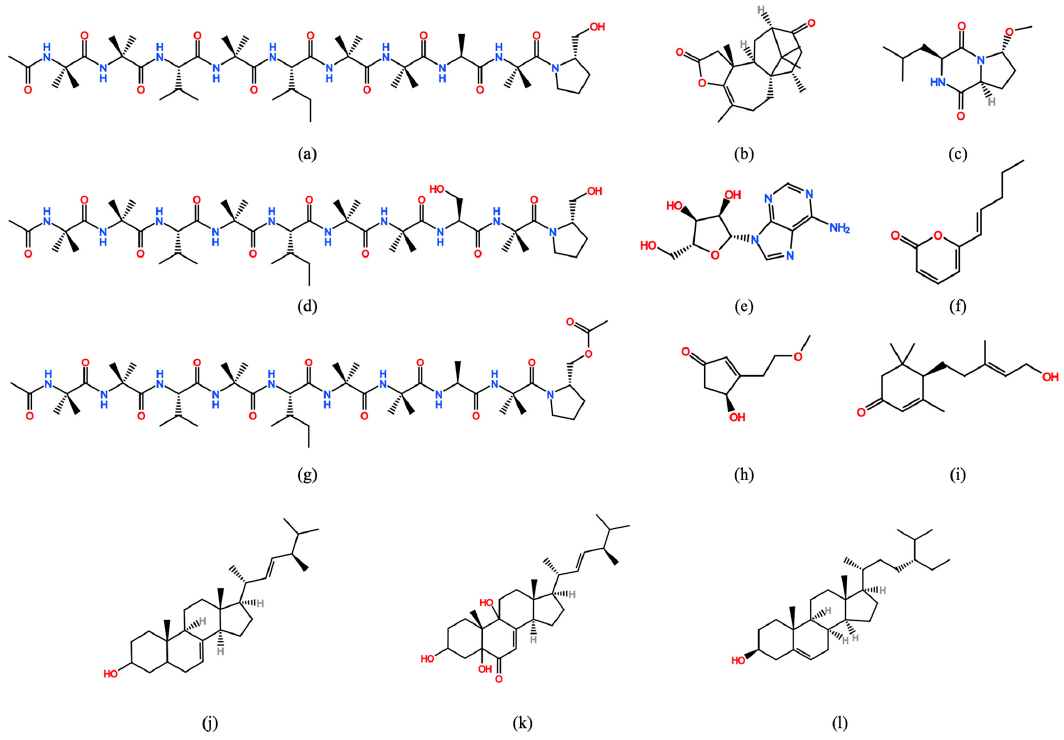
Figure 4. Chemical structure of the nonvolatile compounds (nVOCs) identified in the Trichoderma asperellum (IMI 393899) and Trichoderma atroviride (TS) EtOAc extracts. ( a ) aspereline A; ( b ) trichodermaerin; ( c ) methylcordysinin a; ( d ) aspereline E; ( e ) adenine nucleoside; ( f ) 6-pent-1-enyl-pyran-2-one; ( g ) aspereline H; ( h ) atrichodermone B; ( i ) atrichodermone C; ( j ) ergosta-7,22-dien-3-ol; ( k ) 3,5,9-trihydroxyergosta-7,22-dien-6-one; and ( l ) beta-sitosterol.